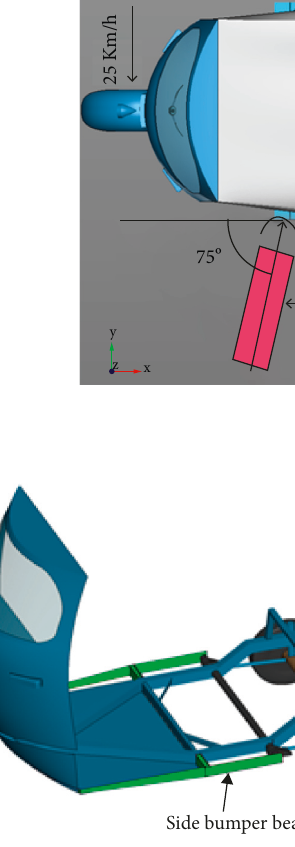
Figure 9: Modified TWV.